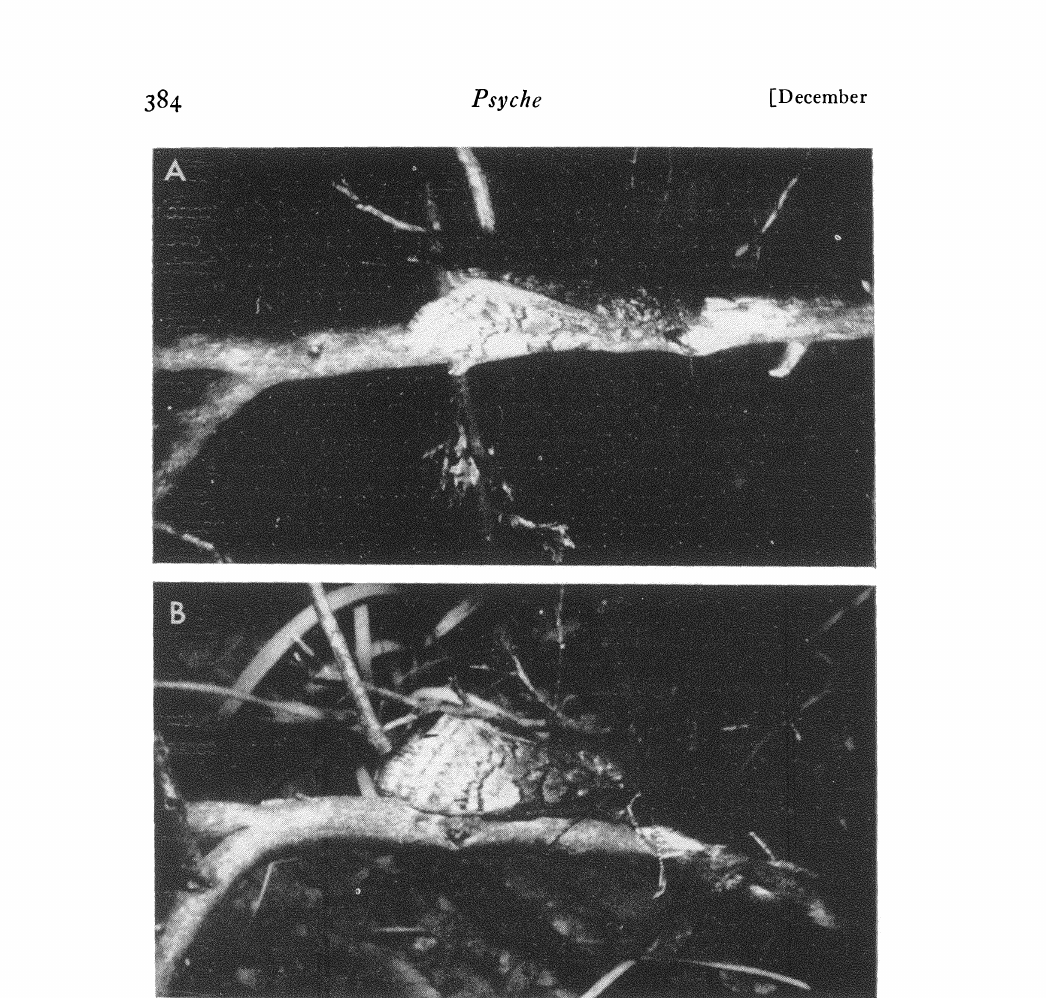
Fig. 1. Female of Erynnis brizo buressi asleep on a branch of Quercus mohriana in Palo Duro Canyon, Texas, at 1720 hours C.S.T. on 12 April 1968. Her head is on the right. For further orientation compare fig. 2. A. Dorsal view of female. B. Right lateral view of